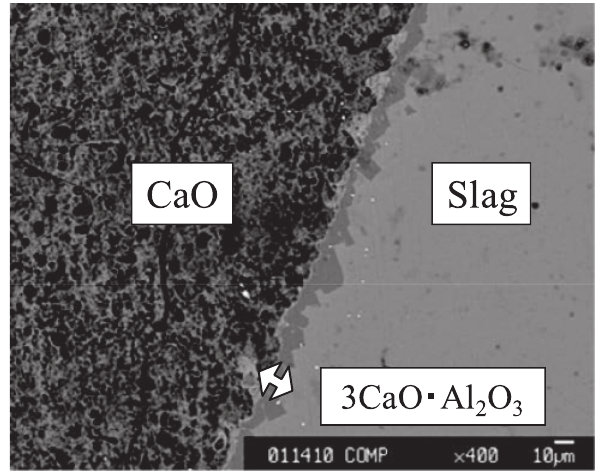
Fig. 13: Cross sectional image of interface between lime and slag when sintered lime (s-Lime) dipped into FeO-CaO-Al